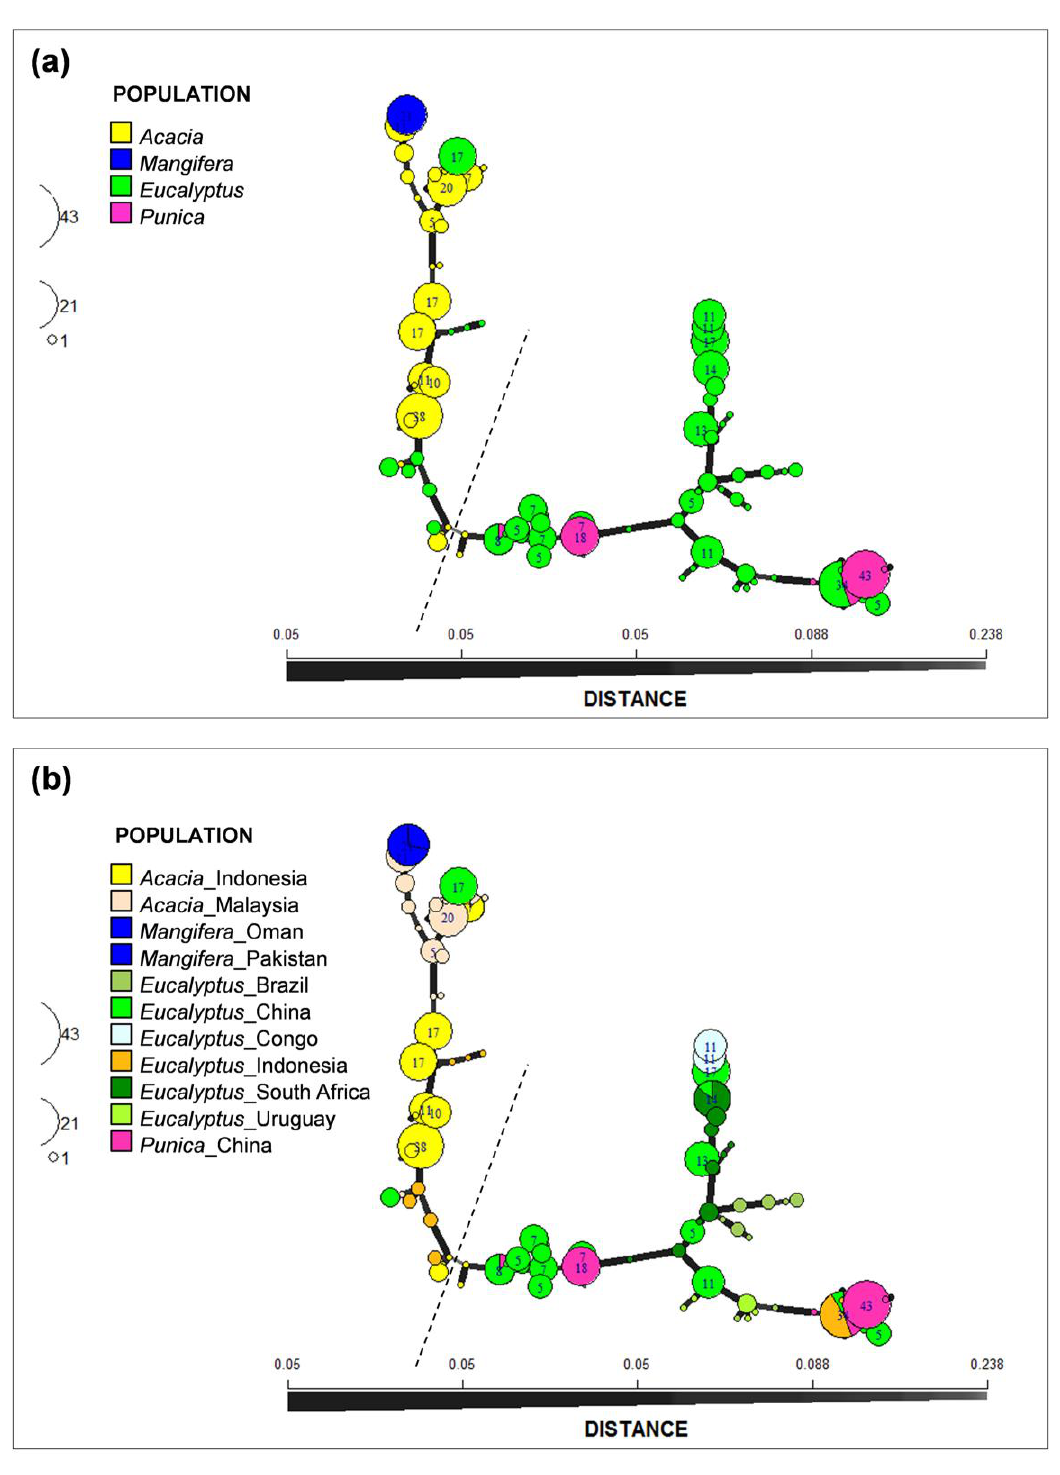
Figure 3. Minimum spanning network constructed using Bruvo’s distances showing two distinct clusters separated by a large genetic distance. The sizes of the nodes are proportional to the number of isolates representing the MLG and the thickness of the lines represent the Bruvo genetic distance between two nodes (thicker lines denote smaller genetic distance). ( a ) Isolates are labeled based on host. ( b ) Isolates are labeled based on host and location. The dashed lines separated the two clusters.